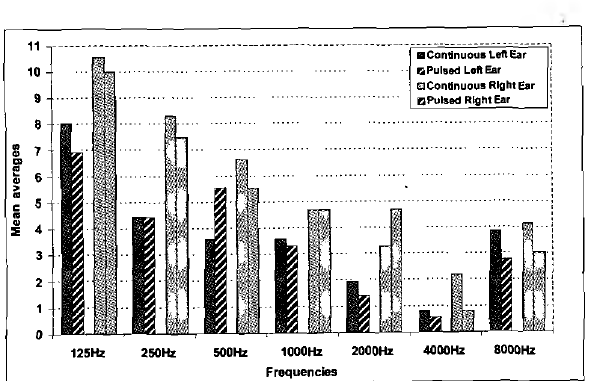
Figure 4: A comparison o f the average hearing thresholds ob­ tainedfor continuous andpulsed tones in each ear